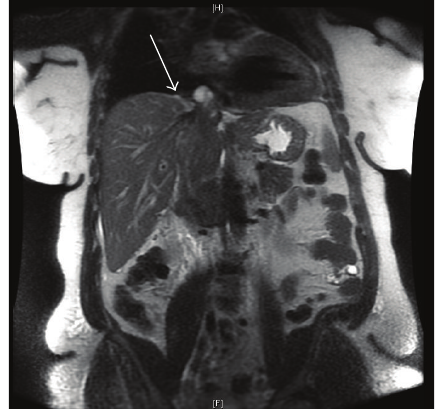
Figure 2: T1 MRI with sagittal view showing the tumor in the IVC with right atrial clot at the tip of the tumor